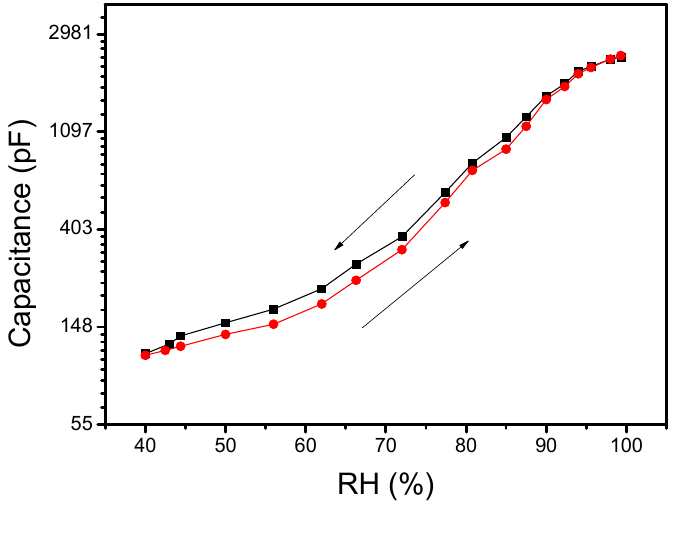
O-PEPC-NiPC/Ag. 2